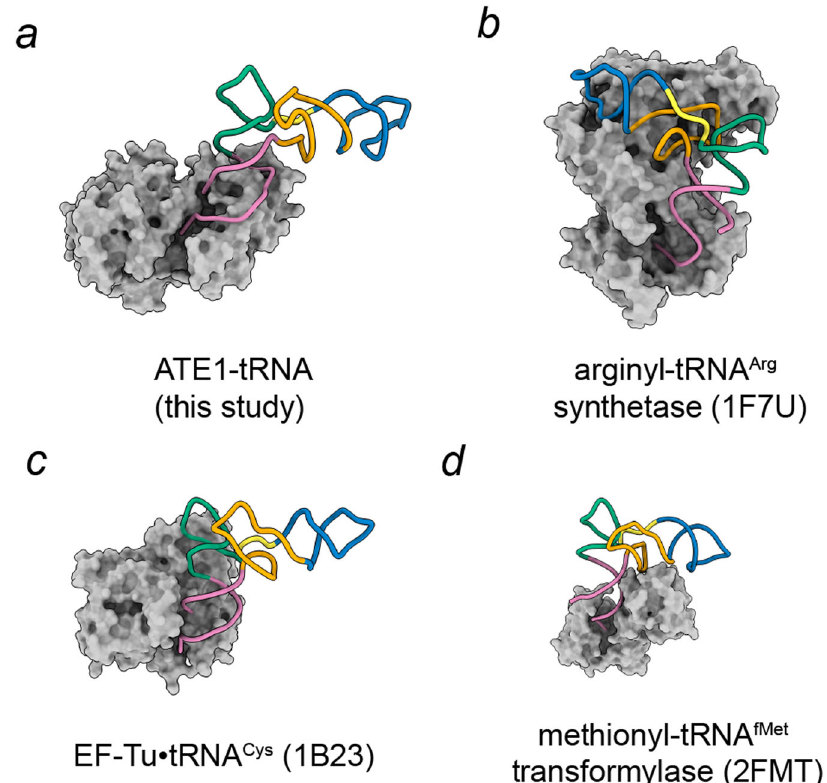
Fig. 4 | Structural comparison of tRNA bound complexes. a Sc ATE1 • tRNA Arg complex in this study. b Arginyl-tRNA synthetase • tRNA Arg complex (PDB entry: 1F7U). c EF-Tu • tRNA Cys complex (PDB entry: 1B23). d Methionyl-tRNA fMet